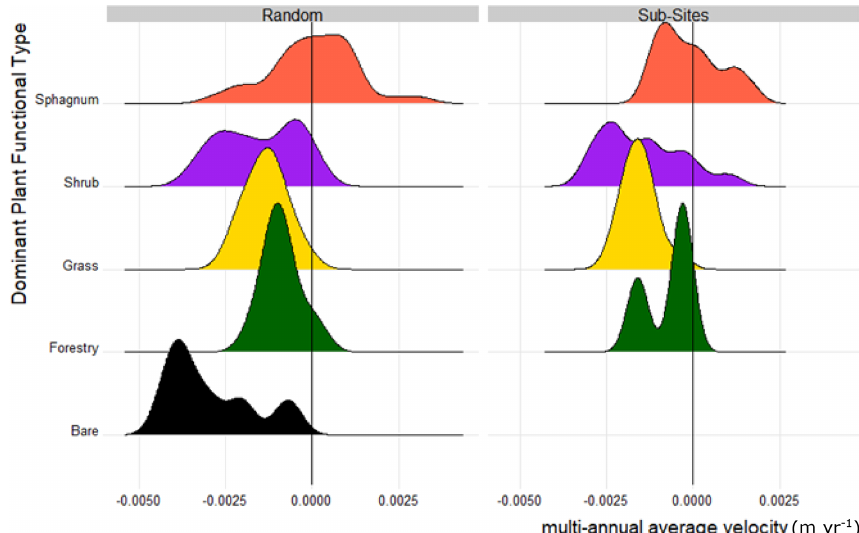
Figure 5. Distribution density of multi-annual velocity for each plant functional group and polygon type plant functional polygons n (random/sub-site): bare – bare peat (6 / 2); forestry – conifer plantation (12 / 3); grasses and rushes – grass-dominated communities (13 / 14); typically Molinia caerulea ; shrub – shrub-dominated communities (59 / 77), typically either or both of Calluna vulgaris and Erica tetralix ; Sphagnum – Sphagnum -dominated communities 35 / 34. Sedges, rushes, and other mosses are also present, often as co-dominant species in both Sphagnum and shrub communities (see Table 2).